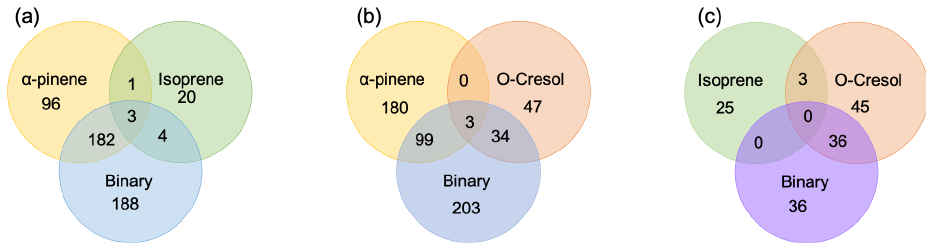
Figure 2. Number of common discrete compounds and unique compounds in single and binary precursor mixed experiments detected by negative-ionization-mode LC-Orbitrap MS. Products are considered identical in the mixed and single precursor systems if the compound has the same empirical formula and a retention time difference <